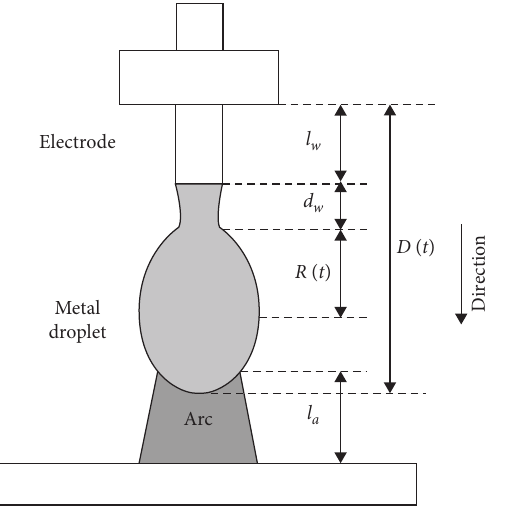
Figure 7: Distance of droplet and workpiece.